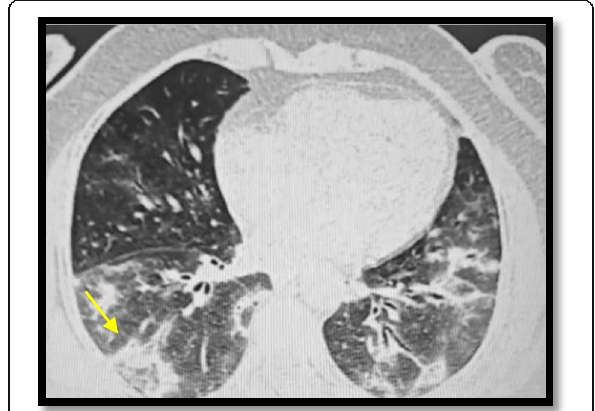
Fig. 4 A male patient, 48 years old, presented with dyspnea and fatigue. MSCT of the chest was done showing bilateral peripheral patchy areas of ground-glass attenuation, with one of them showings characteristic reversed halo sign (arrowed)